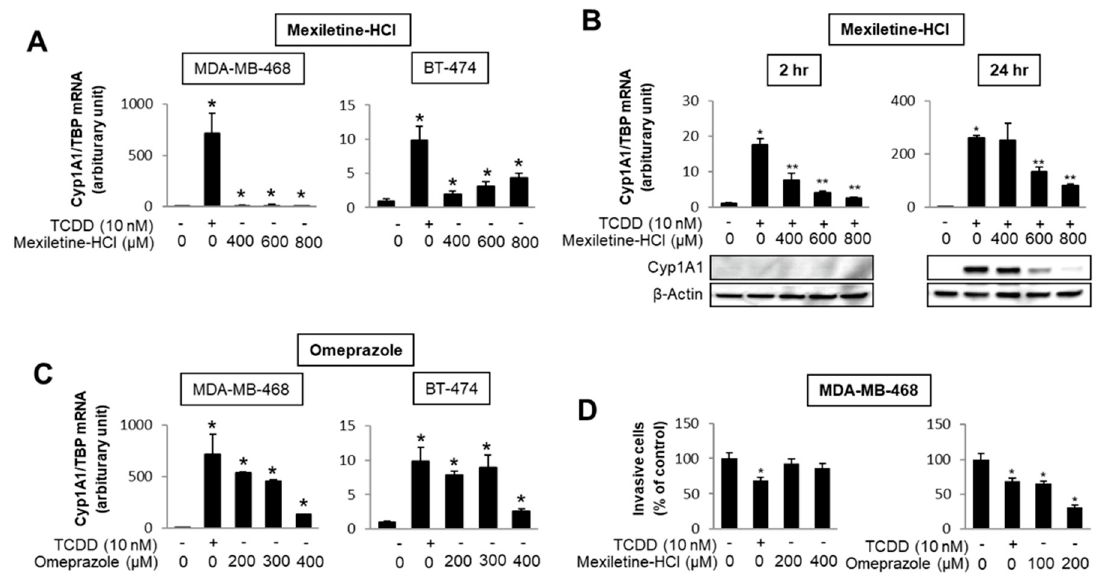
Figure 3. AhR-active pharmaceuticals as selective AHR modulators (SAhRMs). In MDA-MB-468 and BT474 breast cancer cells, mexiletine di ff erentially induces CYP1A1 ( A ) but inhibits 2,3,7,8-tetrachlorodibenzo-p-dioxin (TCDD)-induced CYP1A1 mRNA and protein in MDA-MB-468 cells ( B ). Omeprazole is a potent inducer of CYP1A1 in both MDA-MB-468 and BT-474 cells ( C ) and TCDD and omeprazole, but not mexiletine-inhibited MDA-MB-468 cell invasion ( D ) [109]. Significant ( p < 0.05) induction (*) and inhibition (**) is